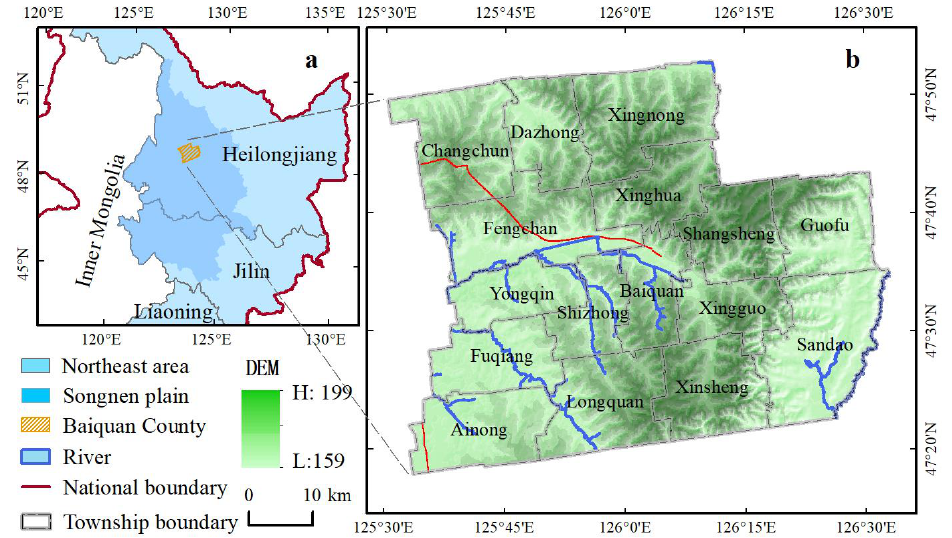
Figure 2. Locations of ( a ) Northeastern China and ( b ) Baiquan County. The study area contains 186 administrative villages with a total village member population of